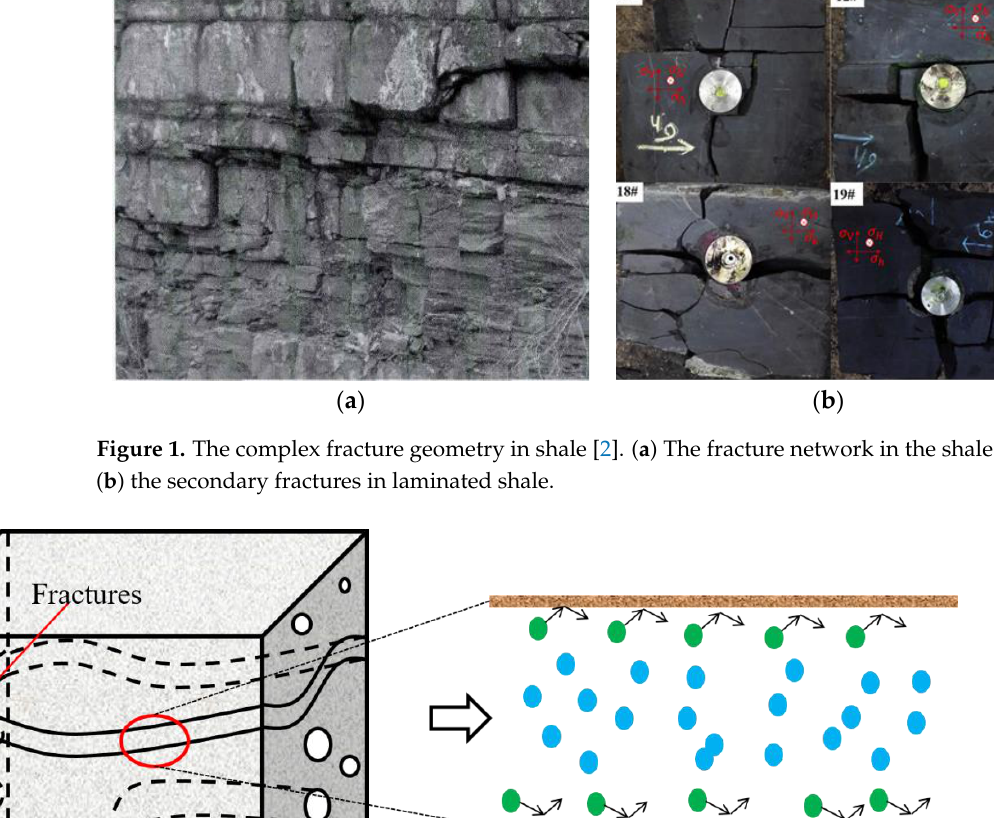
Figure 1. The complex fracture geometry in shale [2]. ( a ) The fracture network in the shale outcrop; ( b ) the secondary fractures in laminated shale.